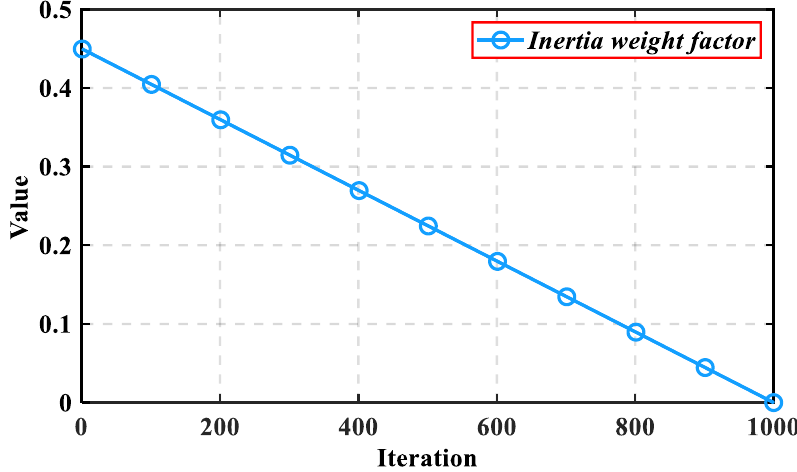
Figure 7. The changing trend of the inertia weight factor.